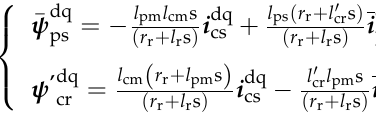
∗ Figure 6. ψ ’ is computed when the speed cr_MTPA Figure 6.   ψ is computed when the speed changes. cr_MTPA Figure 6.   ψ is computed when the speed changes. cr_MTPA